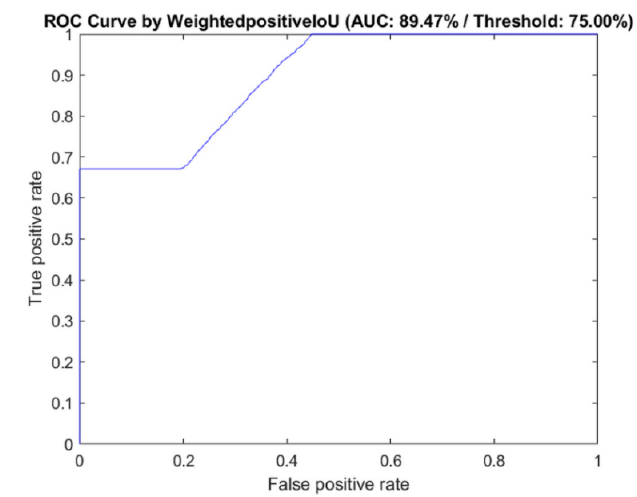
Figure 5. The ROC and AUC of the classification performance based on selected BI-RADS lexicons in the FCN. AUC: area under curve, SVM: support vector machine, BI-RADS—Breast Imaging Reporting and Data System, ROC: receiver operating characteristic curve.